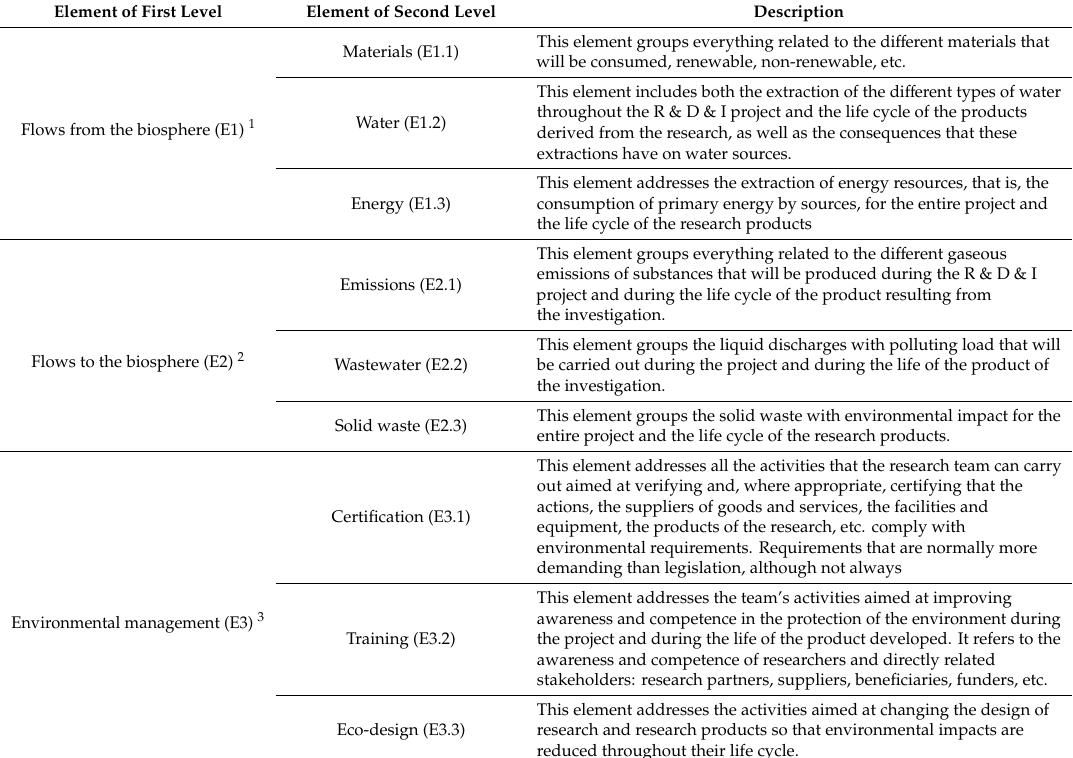
Table A3. Description of the elements of the second